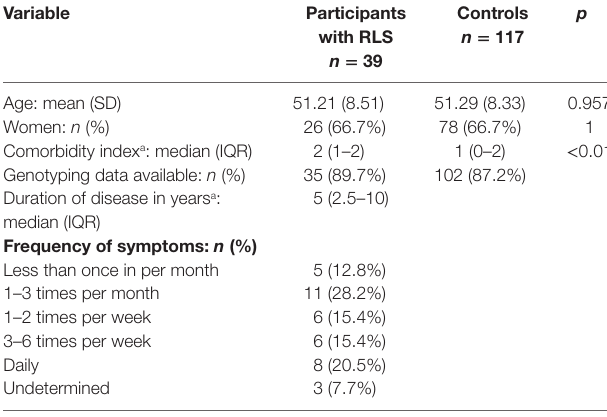
TaBle 1 | Comparison of demographic characteristics across